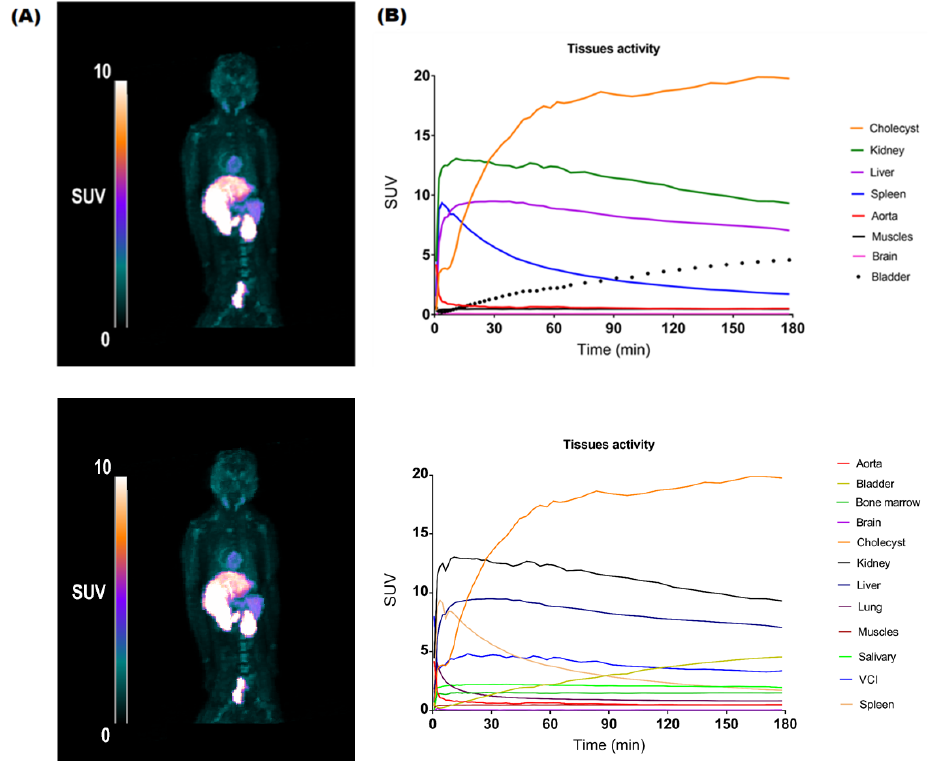
Figure 5. Proof-of-concept of TKI-PET imaging with [ 18 F] (R)- crizotinib (34.8 MBq/kg) in a healthy macaque. ( A ) Whole-body PET-CT imaging at 60 min p.i.; ( B ) time-activity curves of [ 18 F] (R)- crizotinib in blood and major organs.